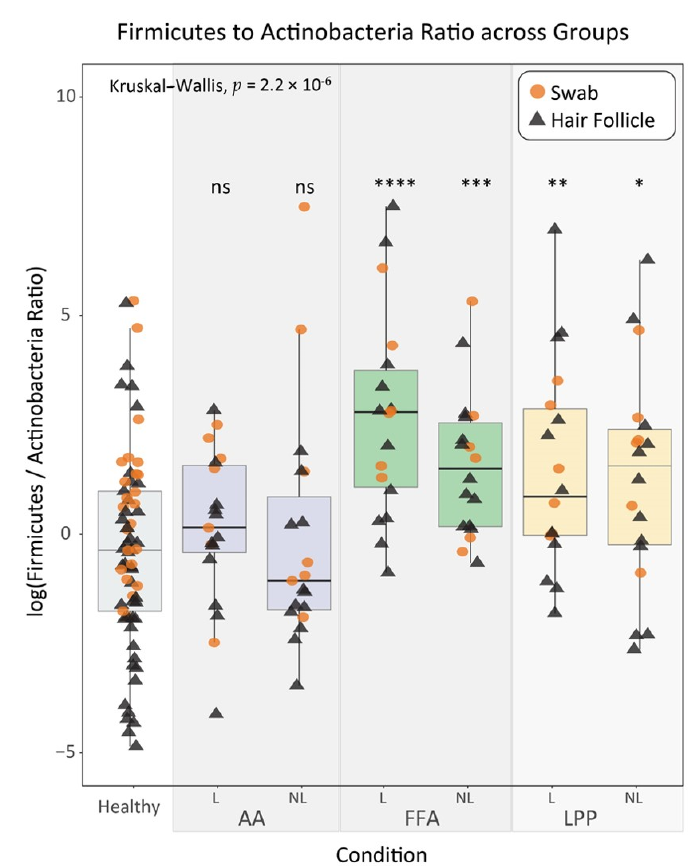
( p -value < 0.05) (Figure 3).